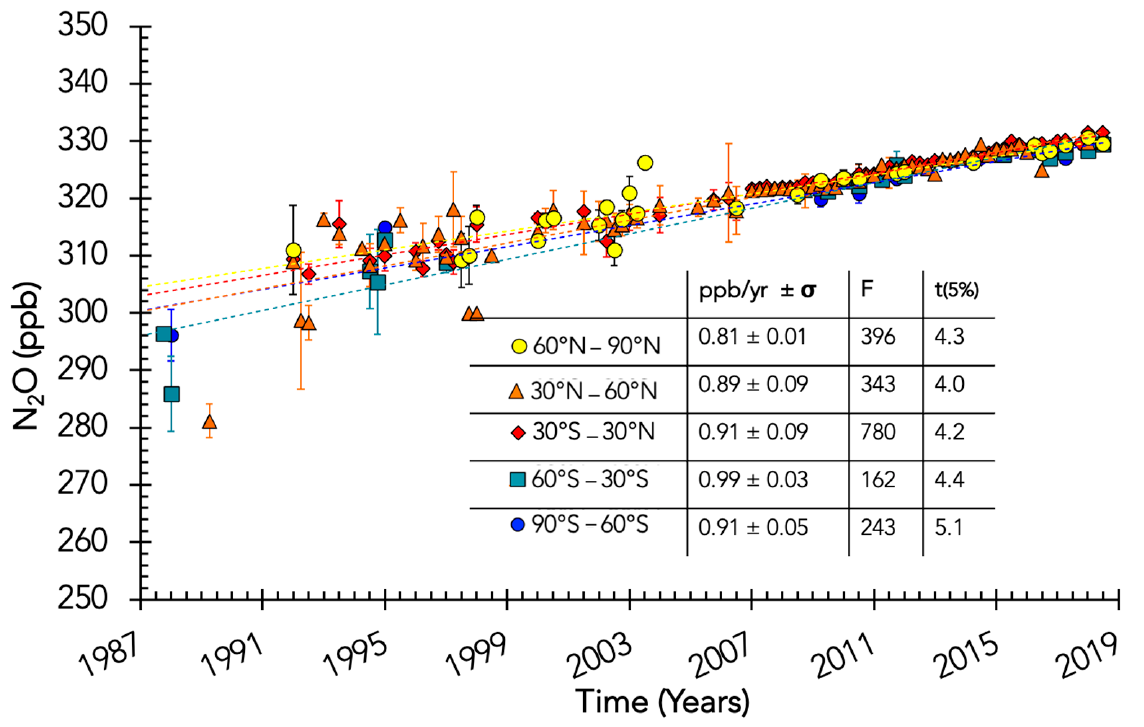
Figure 5. N 2 O trend in the upper troposphere (from +20 to +50 hPa compared to the tropopause pressure) versus time for the South Polar region (deep blue), southern midlatitudes (turquoise), tropics (red), northern midlatitudes (orange) and North Polar region (yellow). The error bars represent the standard deviation for each box (0.25-year range and pressure level). For each latitude band, the slope in ppb/yr is calculated by using linear regression, taking into account the standard deviation of each box; the standard deviation of the slope is also calculated ( σ ) along with the associated F value (Fisher’s test) and the critical t-value at 95% confidence. The more the F value exceeds the critical t-value, the more the trend can be considered linear. Figure 6 shows the trend of N 2 O in ppb per year for all data selected between 1987 and 2018 according to the latitude bands: North and South Polar regions ( ± [90–60] ◦ N), northern and southern midlatitudes ( ± [60–30] ◦ N) and tropics ( ± 30 ◦ ). The vertical axis represents the altitude in pressure relative to the pressure at the tropopause. The interim data from ECMWF [48]. The error bars represent the standard deviation of the slope for the plot concentration versus time (see, e.g., Figure 5). The trends range between 0.8–1.1 ppb/yr in the upper troposphere (up to 350 hPa greater than the tropopause pressure) and 0.64–1.20 ppb/yr in the lower stratosphere (up to 150 hPa less than